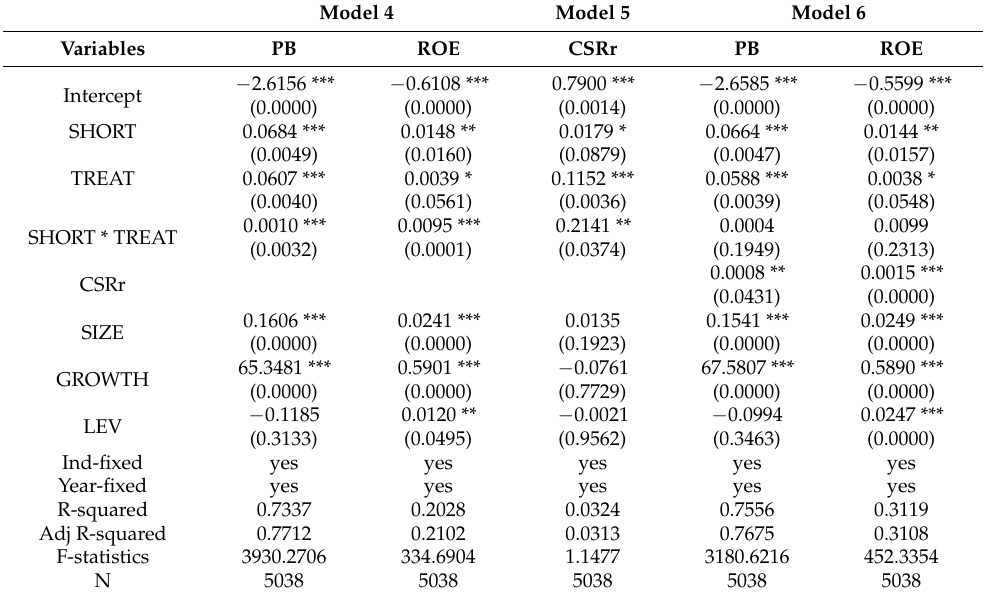
Table 9. Robust test of alternative